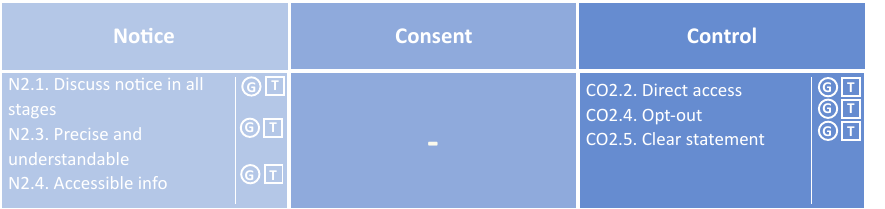
Figure 5. Recommended guidelines reflected in the two LBS developed during the take-home study: “G” and “T” indicate factors that were realised in the GeoFreebie and TourChamp LBS,